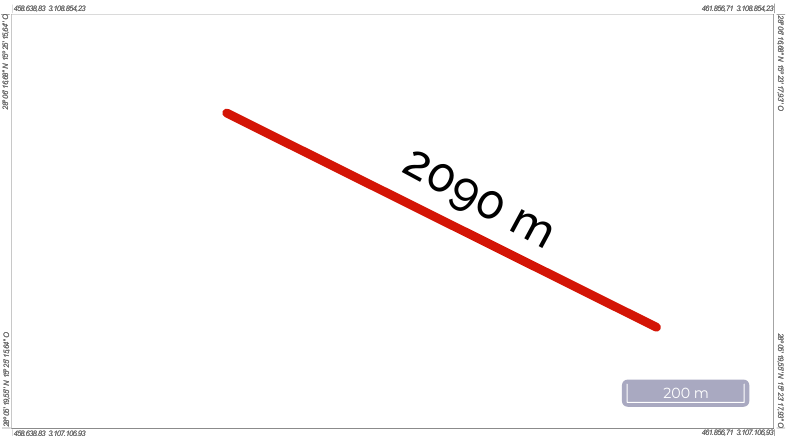
Figure 1. Marine outfall